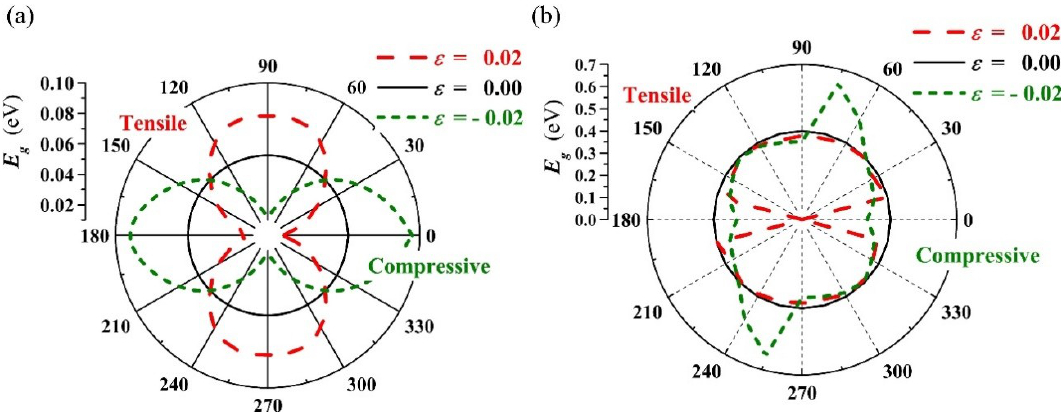
Figure 4. The orientation distribution curves of band gap E g for ( a ) PbPdO 2 , and ( b ) PbPd 0.75 Co 0.25 O 2 with ε = − 0.02, 0.00, 0.02.